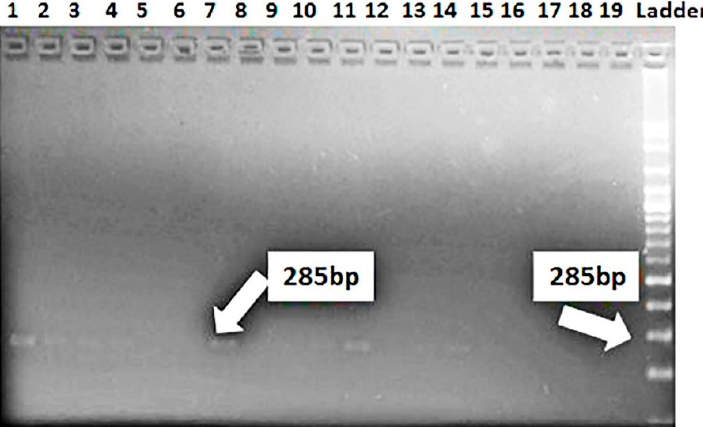
Figure 5. Electrophoretic amplified pattern of DNA extracted from 19 wheat genotypes using the specific primer of Lr37/Yr17 . Lane 1 = Misr-3, Lane 2 = Misr-4, Lane 3 = Misr-2, Lane 4 = Misr-1, Lane 5 = Sids-13, Lane 6 = Gemmeiza-9, Lane 7 = Gemmeiza-12, Lane 8 = Sakha-94, Lane 9 = Sakha-95, Lane 10 = Giza-168, Lane 11 = Gia-171, Lane 12 = Giza-139, Lane 13 = Sids-12, Lane 14 = Sakha-61, Lane 15 = Sids-14, Lane 16 = Gemmeiza-5, Lane 17 = Gemmeiza-7, Lane 18 = Gemmeiza-10, and Lane 19 = Shandweel-1.